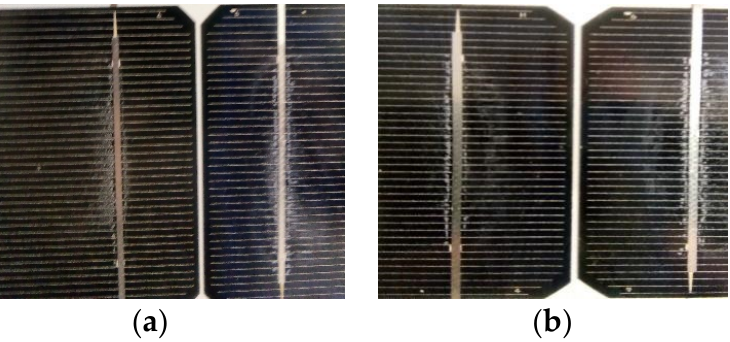
Figure 9. ( a ) I–V characteristic of module no1 captured with the flash tester and converted to STC, ( b ) digital image of the same module showing many cells with severe EVA browning, ( c ) UVF image of same module showing 2 cells with severe EVA browning and neighbouring cells with natural EVA degradation, ( d ) I–V characteristic of M55 module no2, and ( e ) I–V characteristic of SM55 mod- ule no3.